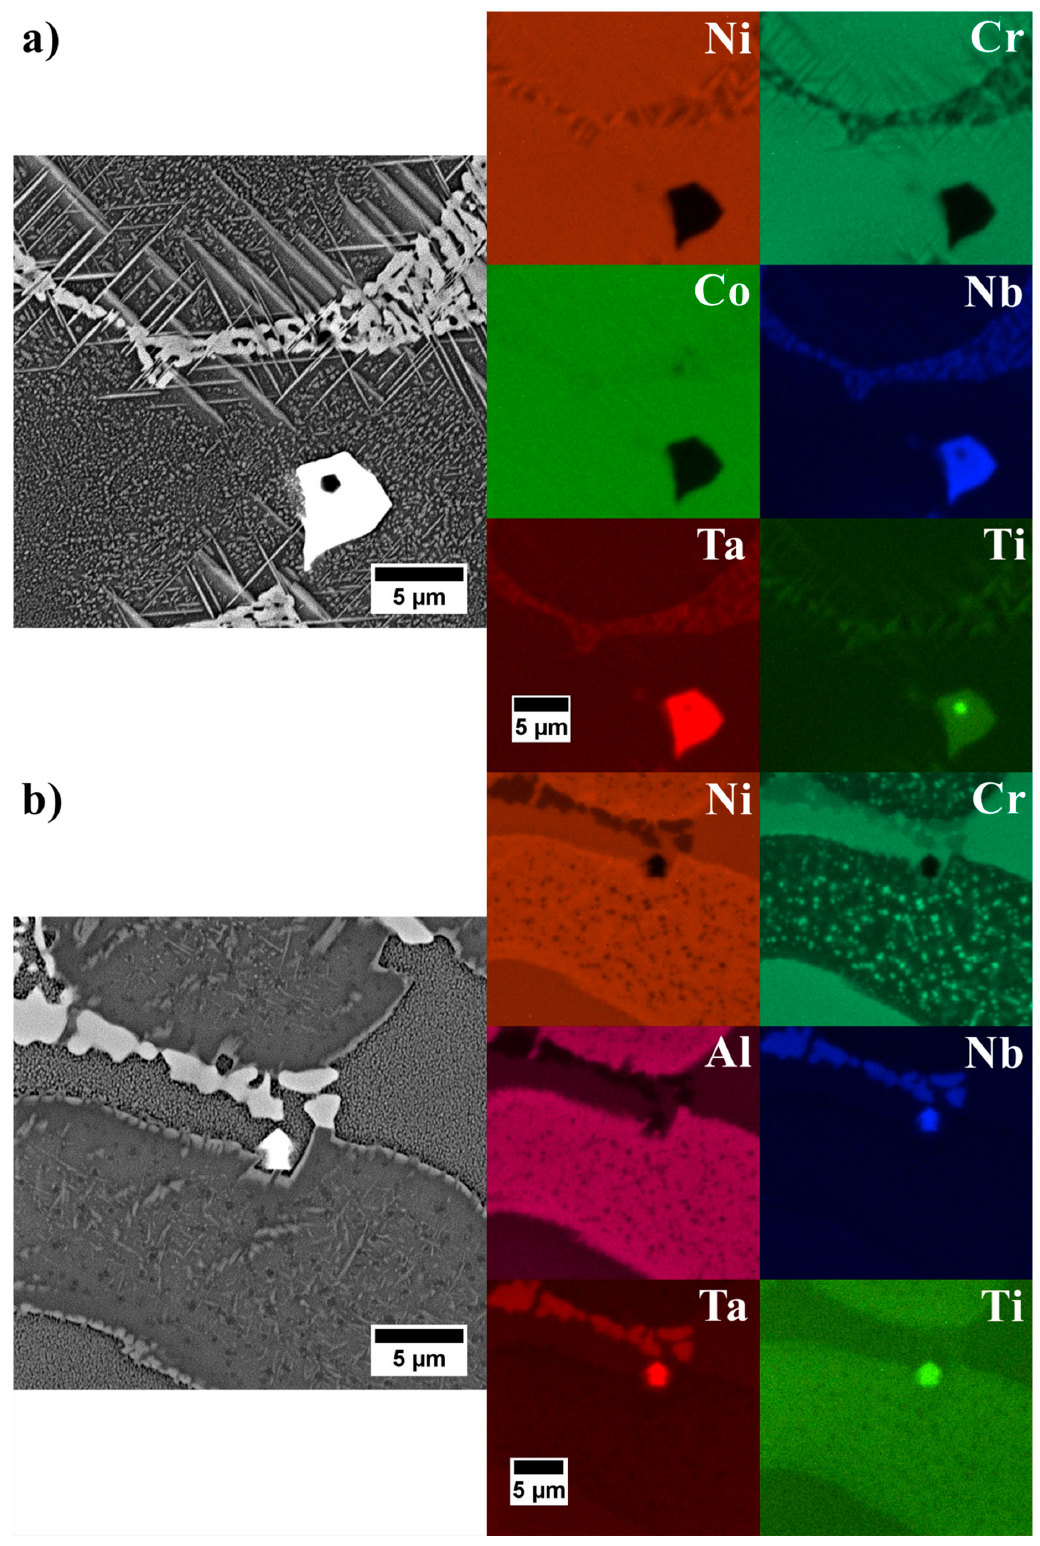
Figure 11. Distribution of selected alloying elements in the interdendritic spaces: ( a ) A1 variant; ( b ) A8 variant.